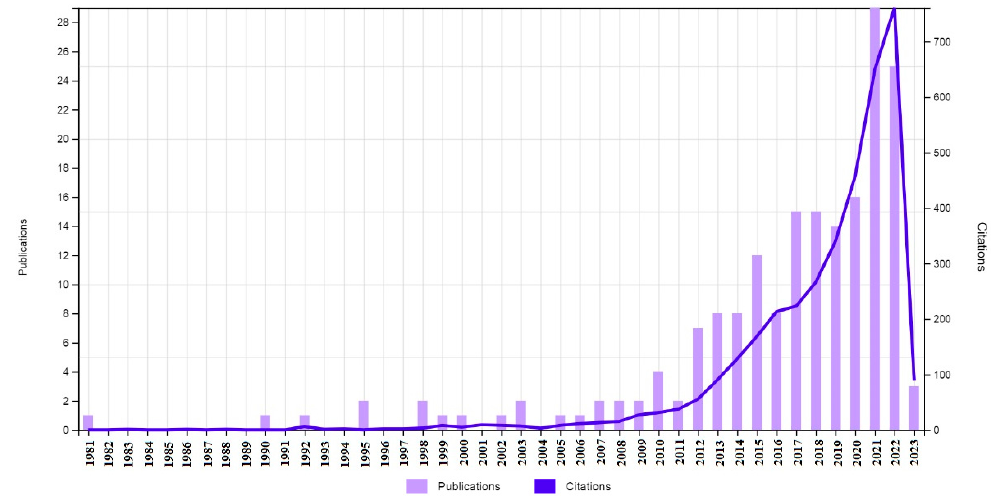
Figure 1. Annual growth of publications and their total citations per year on biodiesel production from essential oil (1981–2023). Table 2. Web of Science (WoS) categories and research areas concerning biodiesel production from essential